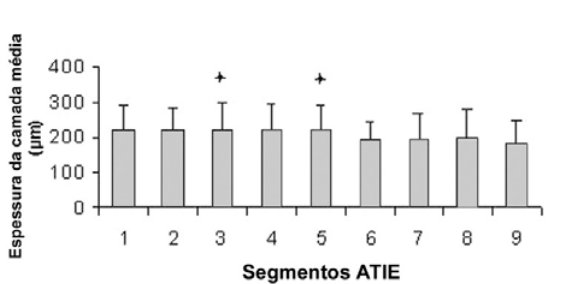
Fig. 4 - A espessura da íntima é aumentada nos segmentos proximal quando comparada aos distais Diferente dos segmentos 2,5,6,7,8,9; p<0,001 Diferente do segmento 3; p<0,05